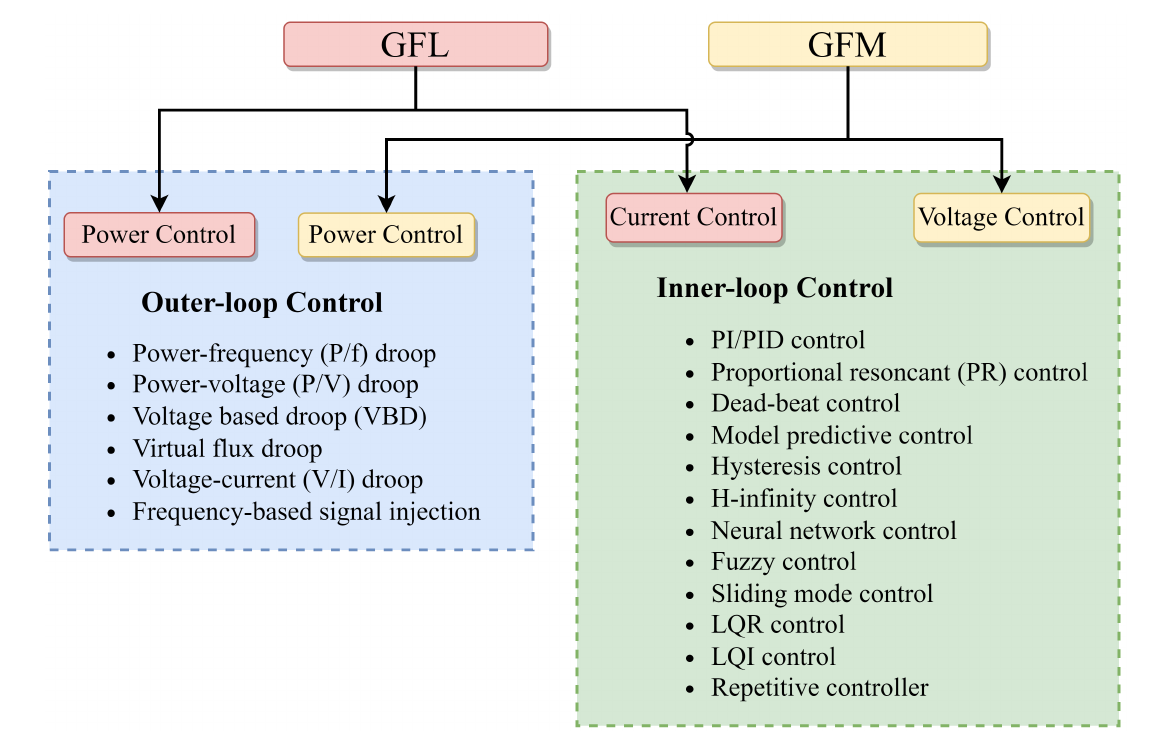
Figure 4. Generalized control structure of VSC / VSI topologies.